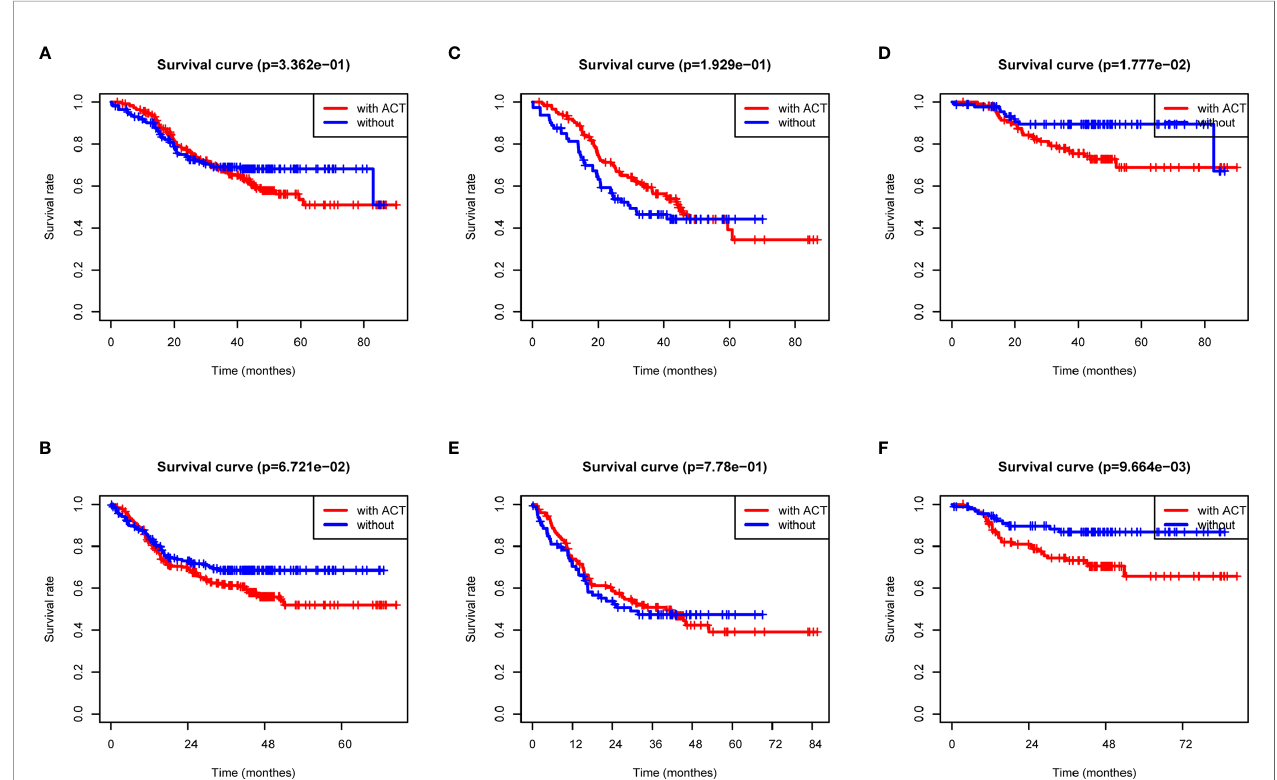
FIGURE 4 | ACT bene fi t analysis based on the radiomics score. (A) Overall survival analysis of all GC patients according to ACT. (B) Disease-free survival analysis of all GC patients according to ACT. (C) Overall survival analysis of low-radiomics score GC patients according to ACT. (D) Overall survival analysis of high-radiomics score GC patients according to ACT. (E) Disease-free survival analysis of low-radiomics score GC patients according to ACT. (F) Disease-free survival analysis of high-radiomics score GC patients according to